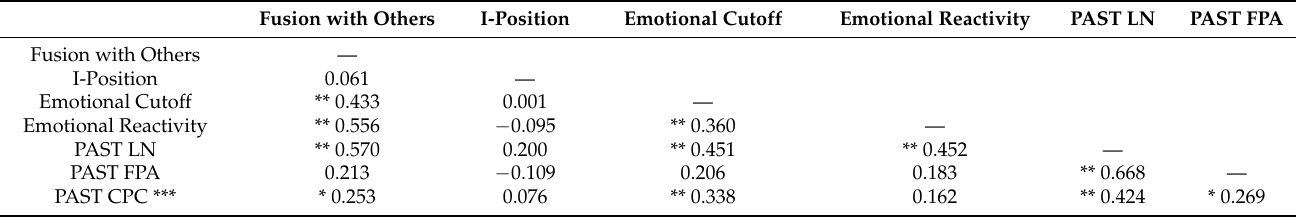
Table 5. Summary of significance levels for differentiation of self-inventory-short form and psychological adjustment to separation test correlations ( N = 84).